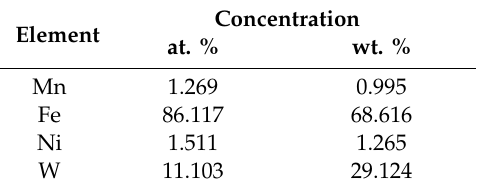
Table 9. The elemental composition of the carbide coating matrix (3—Figure 9). Concentration Element at. % wt. %